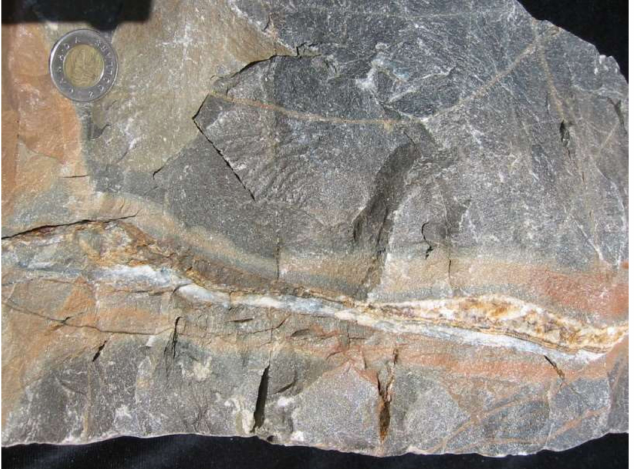
Figure8. Photographdisplayingaquartz–carbonatevein, roughly0.7cminwidth, whichiscross-cutting